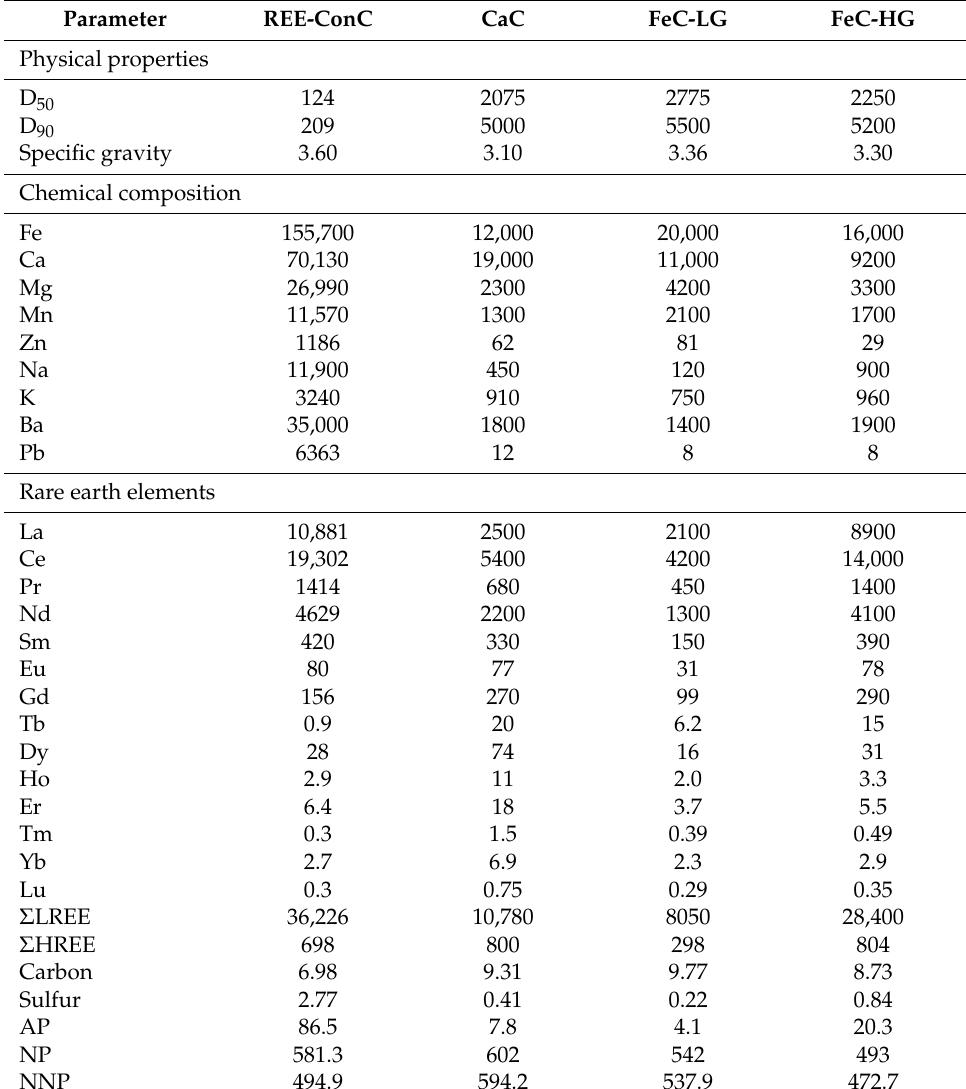
Table 1. Chemical and ABA characterization of the samples studied (elements in mg/kg; carbon and sulfur in %; AP, NP and NNP in kg CaCO 3